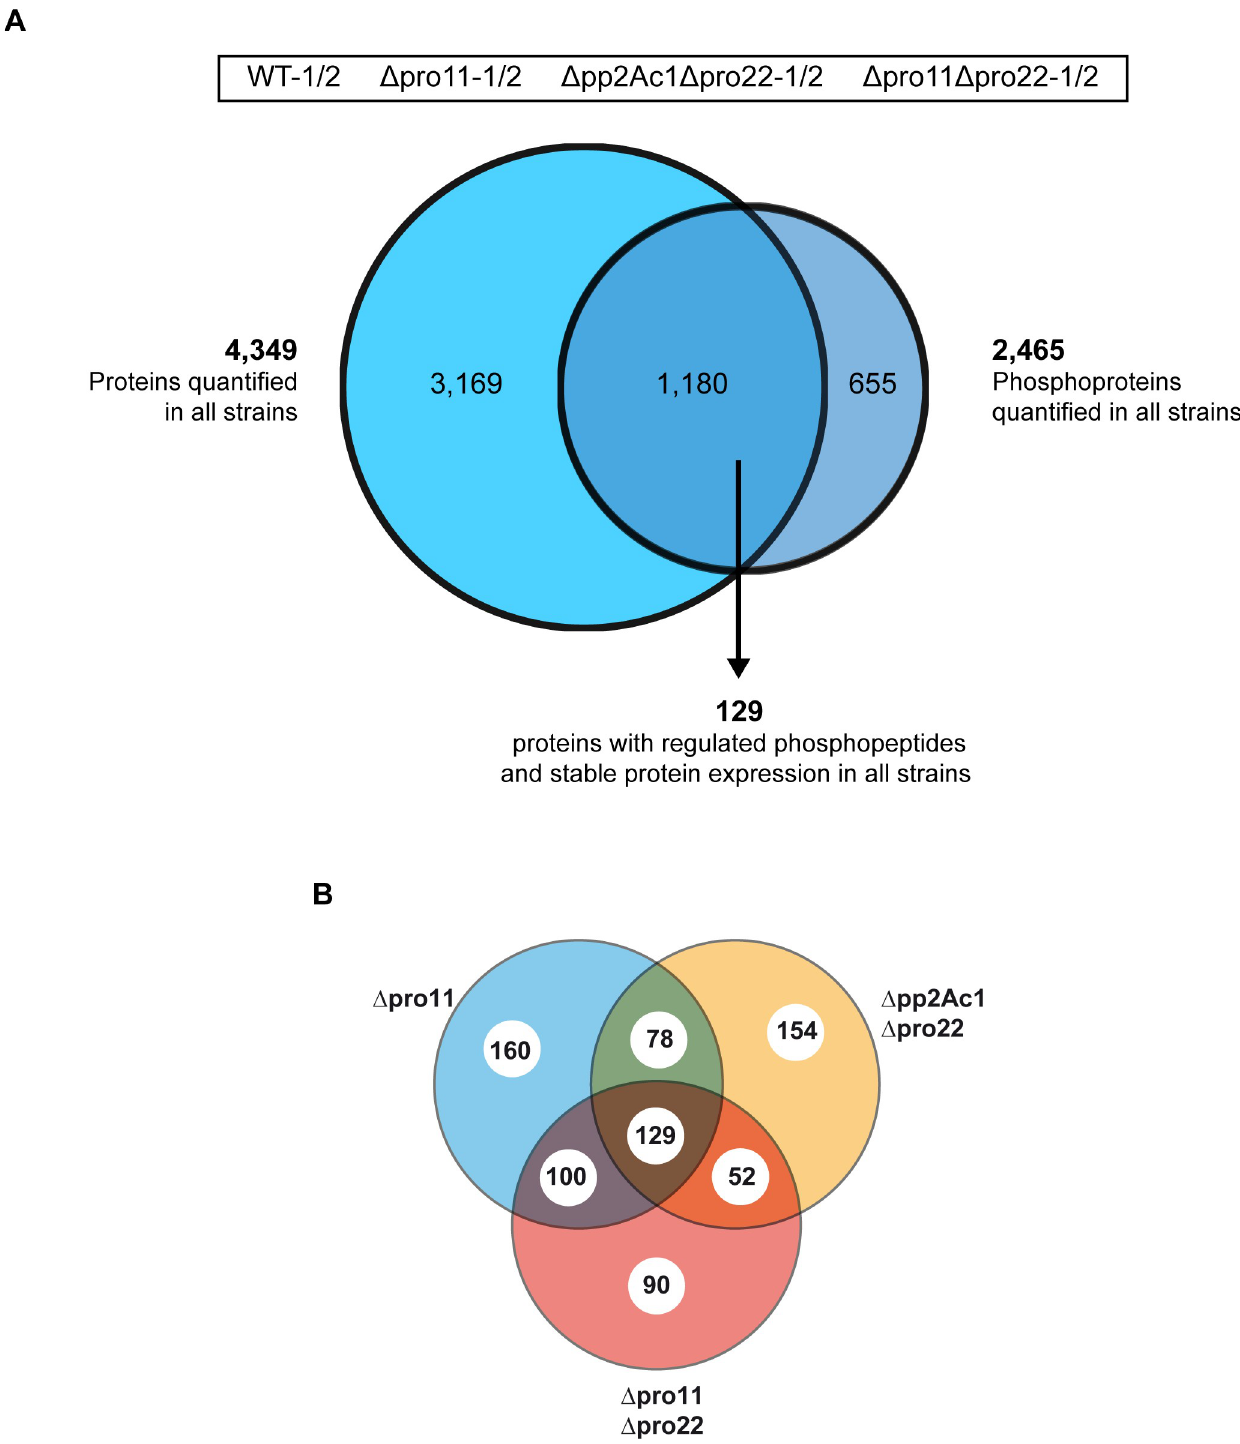
Fig 1. Proteins and phosphoproteins found in the wild type and three STRIPAK deletion strains. (A) We analysed the proteome and the phosphoproteome of the wild type, Δ pro11, Δ pp2Ac1 Δ pro22 and Δ pro11 Δ pro22. In total, we identified 4,349 proteins in all strains and 2,465 phosphoproteins. The intersection of the Venn diagram gives the number of proteins found in both, the protein and the phosphoprotein analyses (1,180). Moreover, the number of regulated phosphoproteins from all strains are given that were identified with similar abundances in the global proteome. (B) Venn diagram of 129 phosphoproteins with regulated phosphorylation sites in STRIPAK deletion strains. Given is the total number of 129 phosphoproteins in the intersection of the Venn diagram which are differentially phosphorylated in Δ pro11, Δ pp2Ac1 Δ pro22, Δ pro11 Δ pro22. Some phosphoproteins are given in more than one intersection because they exhibit multiple regulated phosphorylation sites (see also S1 and S2 Datasets). https://doi.org/10.1371/journal.pgen.1008819.g001 PLOS Genetics | https://doi.org/10.1371/journal.pgen.1008819 September 30,